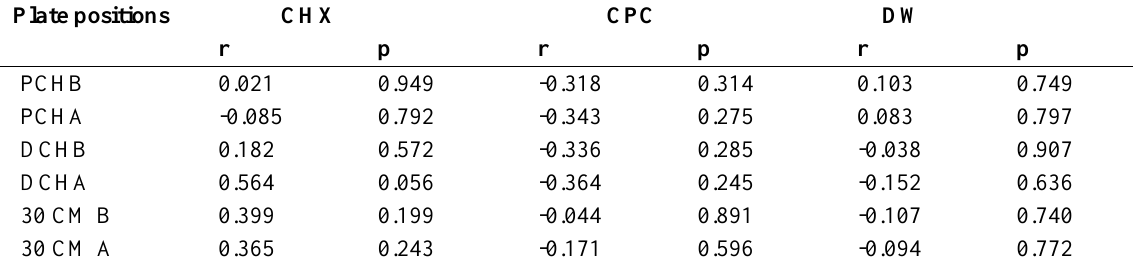
Table 2: The statistical correlation between plaque index and the colony count of aerosol bacteria in all mouthwashes groups, locations and